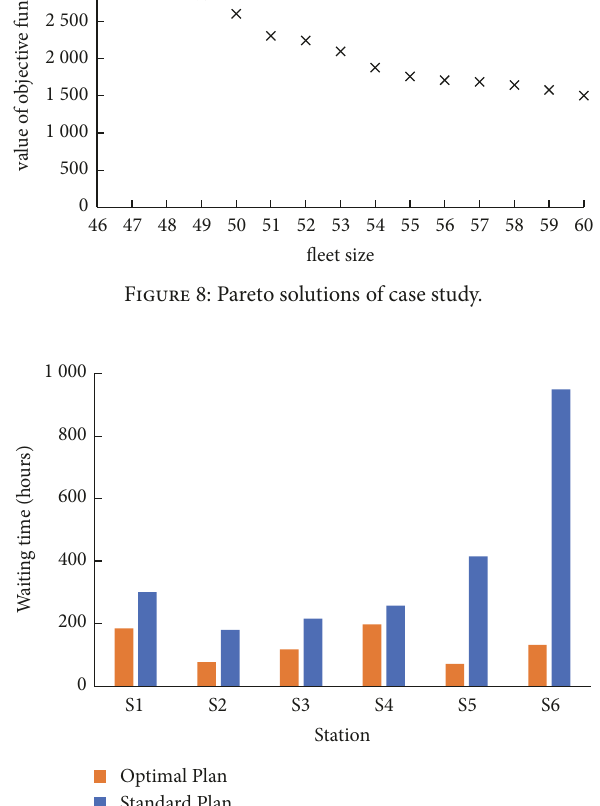
Figure 9: Comparing of waiting time at each station in upward direction before and after